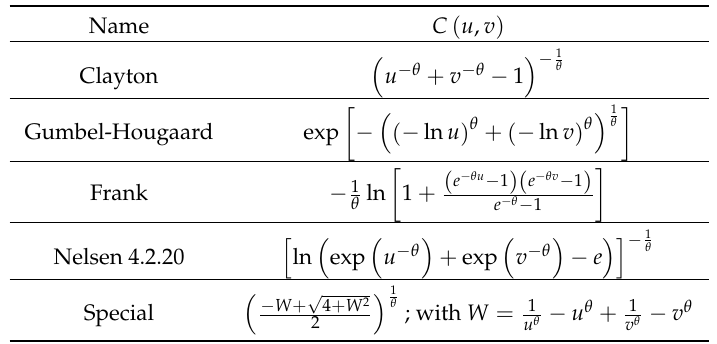
Table 1. Archimedean single-parameter copulas